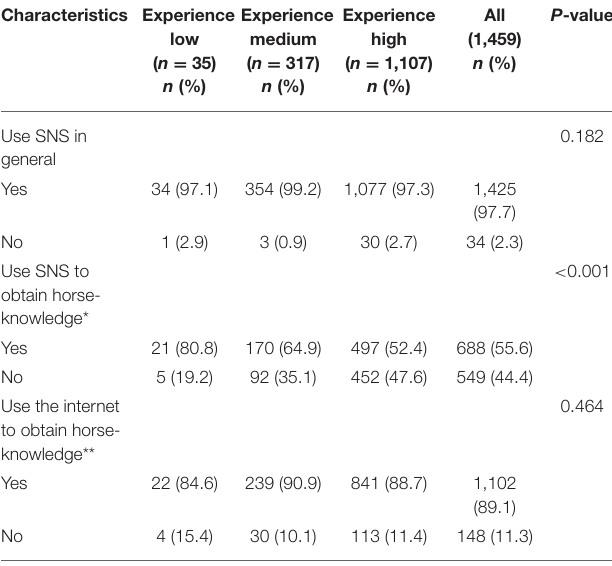
TABLE 3 | Characteristics of Swedish and Norwegian riders’ use of ICTs in relation to horse experience. Characteristics Experience